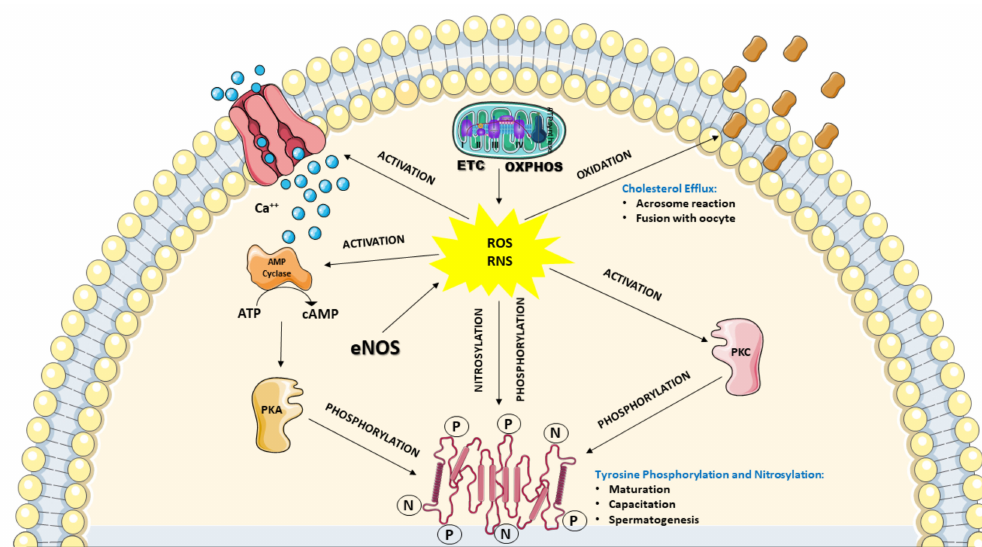
Figure 2. Schematic representation of the involvement of ROS and RNS to ensure the correct development and function of spermatozoa. In functional mitochondria, the correct coupling between ETC and OXPHOS ensures an adequate ATP supply for cell energy demand, as well as a “physiologic” flux of ROS (mainly in the form of superoxide anion). At the same time, the endothelial (and possibly the neuronal) nitric oxide synthase isoform (eNOS) provides “physiologic” production of RNS (in the form of nitric oxide). These controlled amounts of ROS and RNS positively affects numerous intracellular processes of spermatozoa, including; (i) influx of calcium ions (Ca ++ ) triggering the cyclic AMP (cAMP) cascade (increase in adenylate cyclase activity) leading to activation of protein kinase A (PKA) which catalyzes the phosphorylation of numerous target proteins; (ii) the concomitant activation of protein kinase C (PKC), producing a further increase in protein phosphorylation; (iii) regulation of protein activities through nitrosylation reactions; (iiii) oxidation of cholesterol and removal from the plasma membrane. Some of these processes are deeply involved during spermatogenesis, maturation and capacitation, as well as in acrosome reaction and fusion with the oocyte. Due to these functions in their life cycle, spermatozoa may be defined as “professional generators” of ROS and RNS. During these ROS and RNS-mediated processes, no significant depletion in the antioxidant heritage of spermatozoa